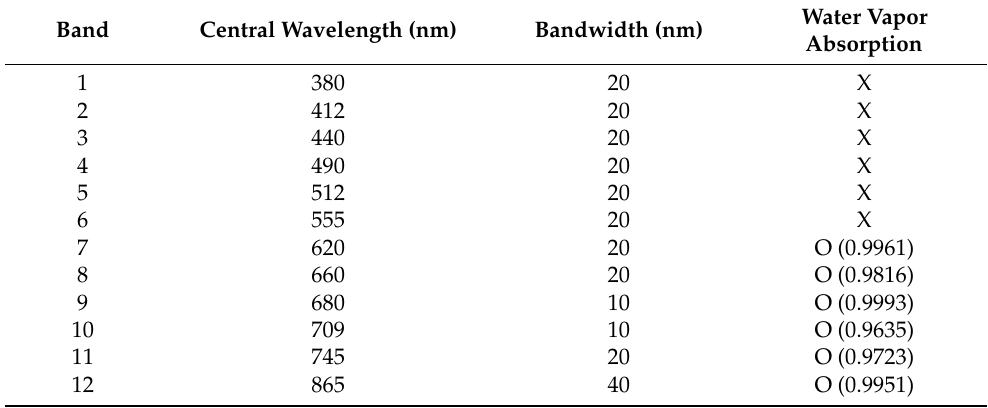
Figure 1. The observation area of geostationary ocean color imager (GOCI-II) ( left ) full-disk and ( right ) local area mode. The observation area of each slot (dashed boxes) for local area mode is overlaid on a background image of the Korean peninsula. Radiosonde observation locations are indicated by blue “X” symbol. Orange shading indicates the observation area of slot 7. Table 2. GOCI-II spectral specifications. The number in parentheses means the water vapor transmittance for an air pressure of 1013 mb, total precipitable water (TPW) of 3 g/cm 2 , and zenith angle of 30°.